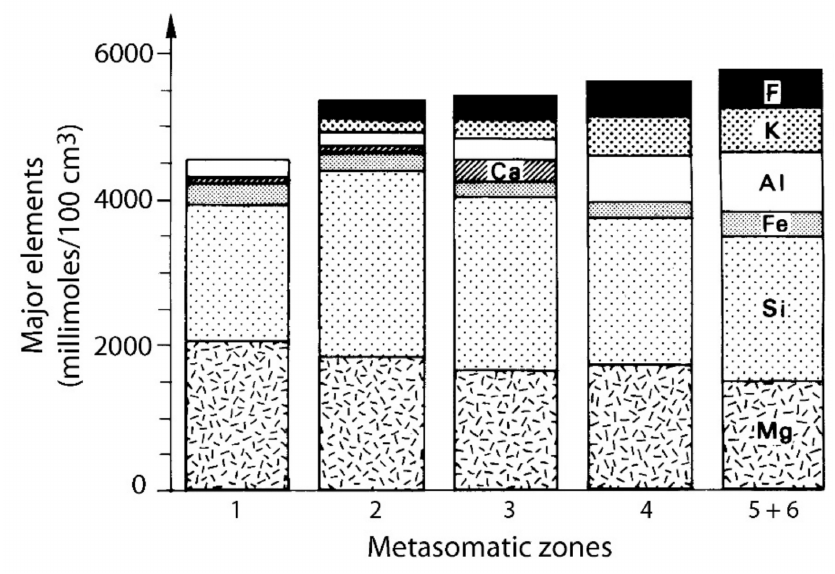
Figure 16. Mass balance calculations realized on the metasomatic column at Bode prospecting pit, Carna í ba mine, Bahia, Brazil (modified from [79]). Chemical mass balance was realized on major elements’ molar composition (in millimoles/100 cm 3 ) of the different metasomatic zones (1 to 5 + 6). It indicates the supply of many elements, such as K, Si, Al, and F, over the whole column, and Fe, in the inner most zones of 6 and 5, the leaching of Mg and Ca from the outer to the inner